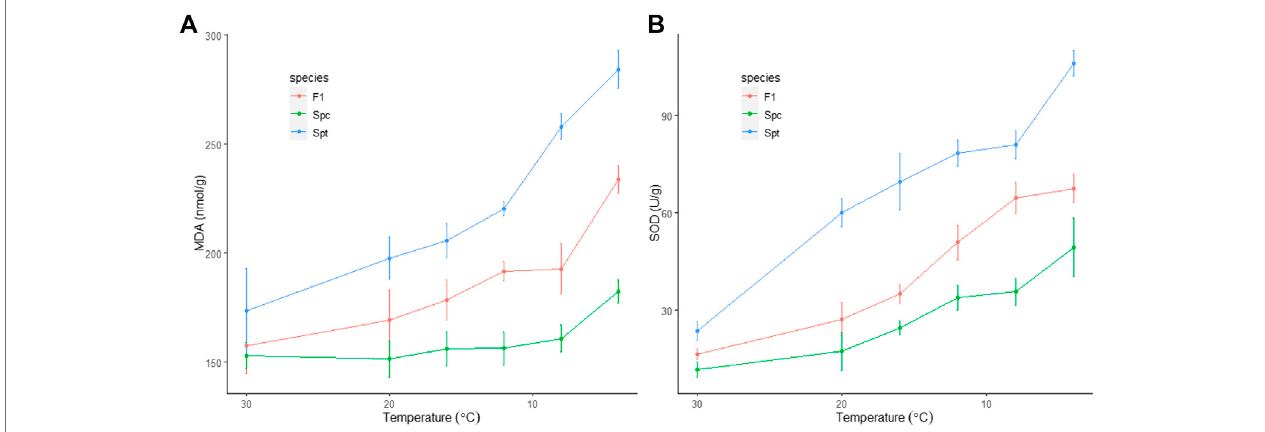
FIGURE 1 | Physiological responses to consecutive chilling stress among the invasive Sphagneticola trilobata , the native S. calendulacea and their F1 hybrid. (A) Malondialdehyde (MDA) concentration; (B) Superoxide dismutase (SOD) activity.